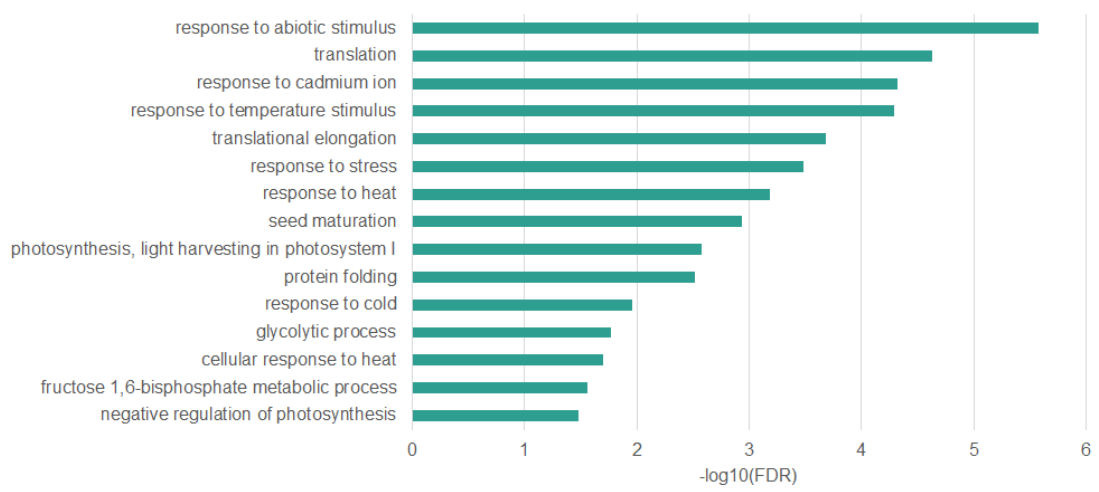
Figure 8. Biological processes overrepresented in Arabidopsis thaliana genes differentially methylated in all sequence contexts (CpG, CHG, CHH).